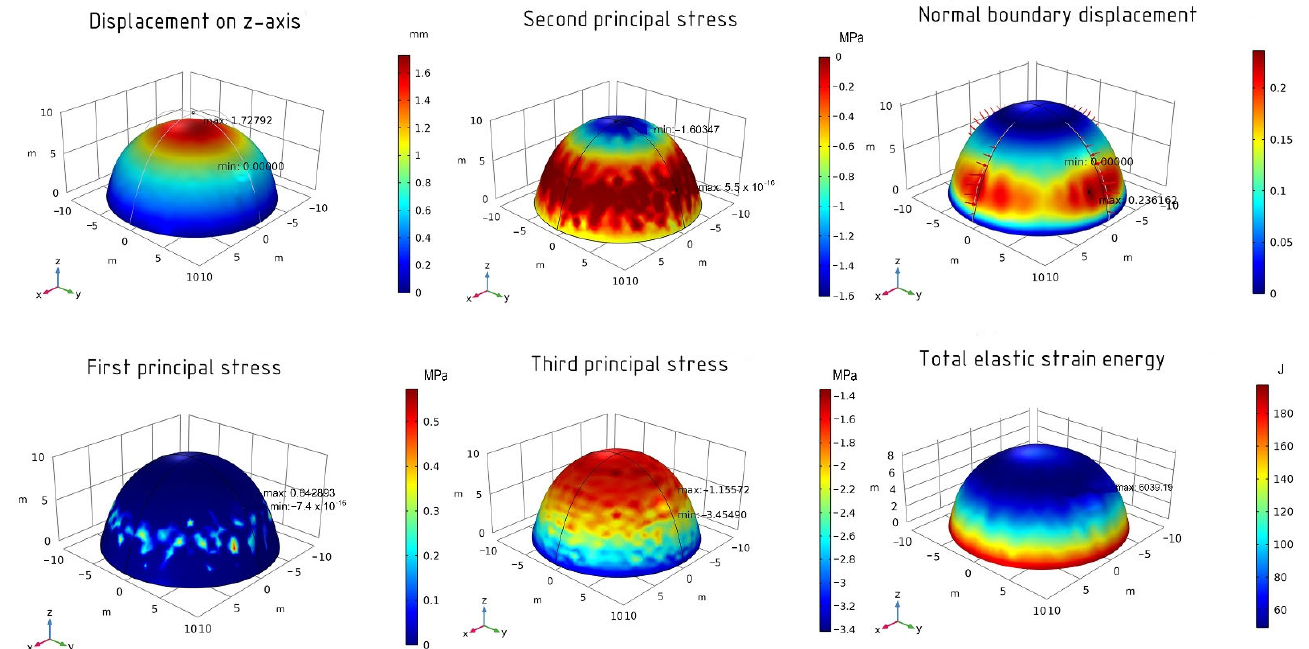
Figure 13. The results of the optimized shell using the MMA method.